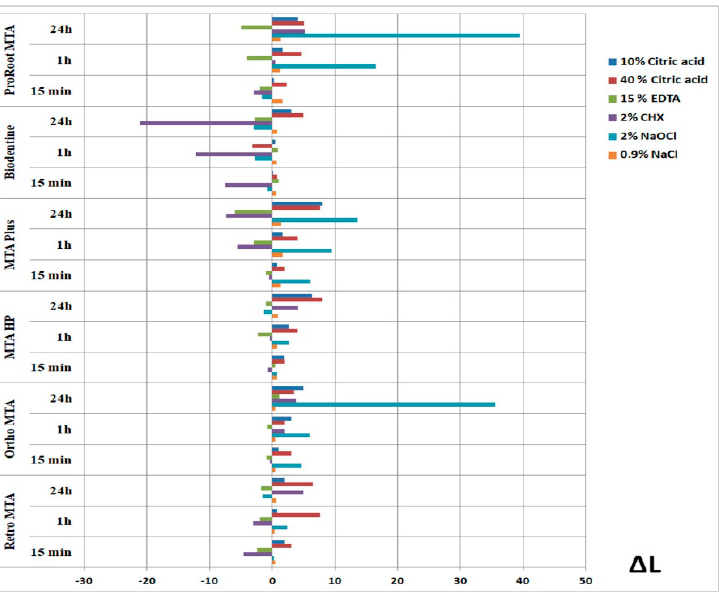
Figure 4. Mean Δ L values of CSCs materials after contact with irrigation solutions for different durations.